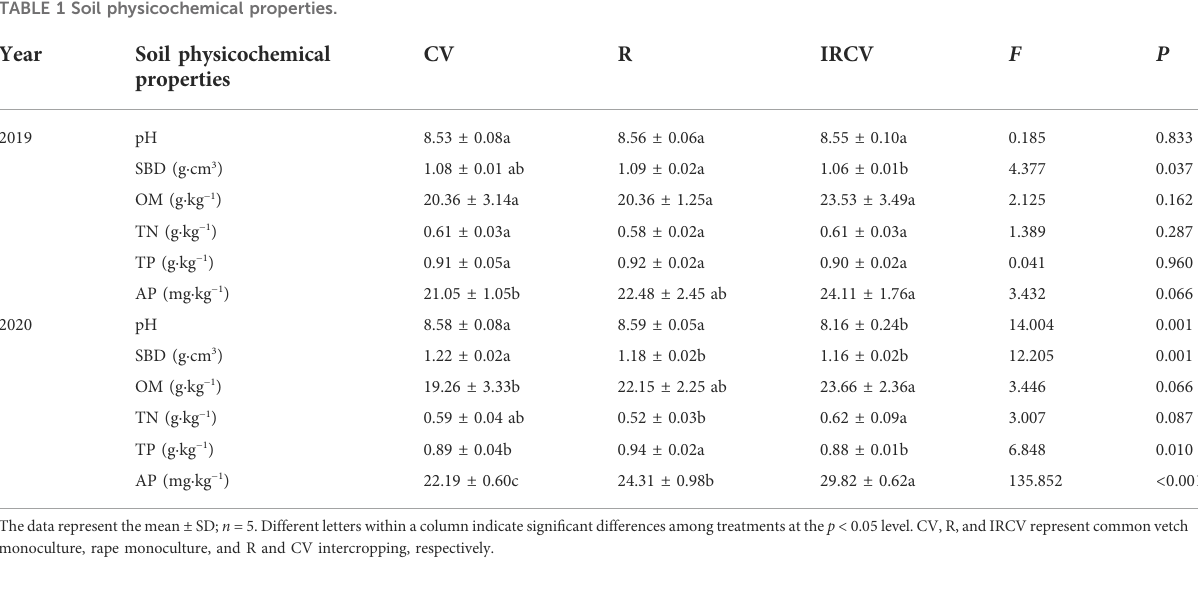
(Figure 5A). The relative